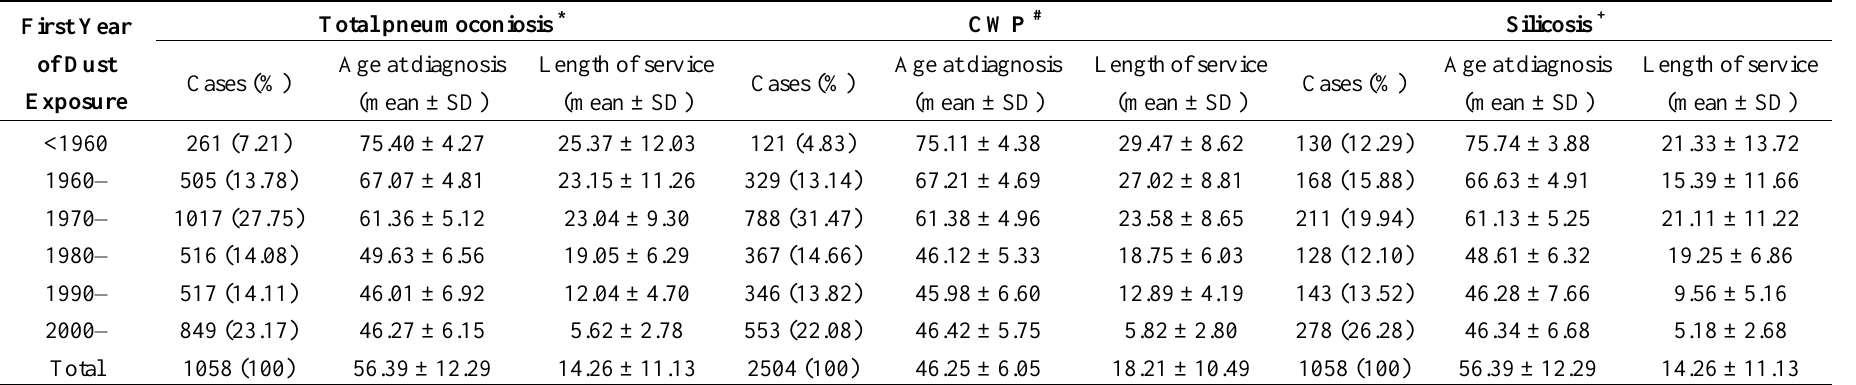
Table 2. Incidence of pneumoconiosis according to year of first dust exposure.